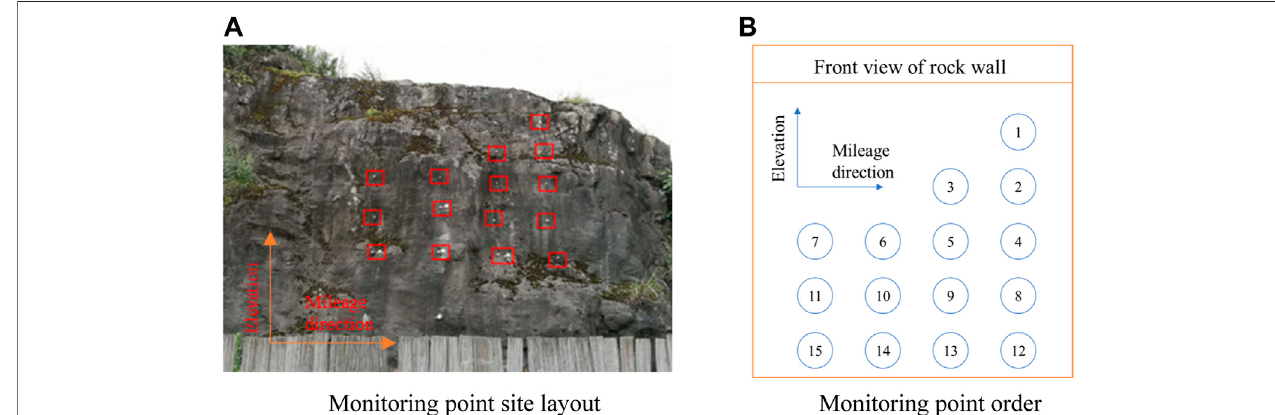
FIGURE 10 | Site layout and detail arrangement of 15 monitoring points.